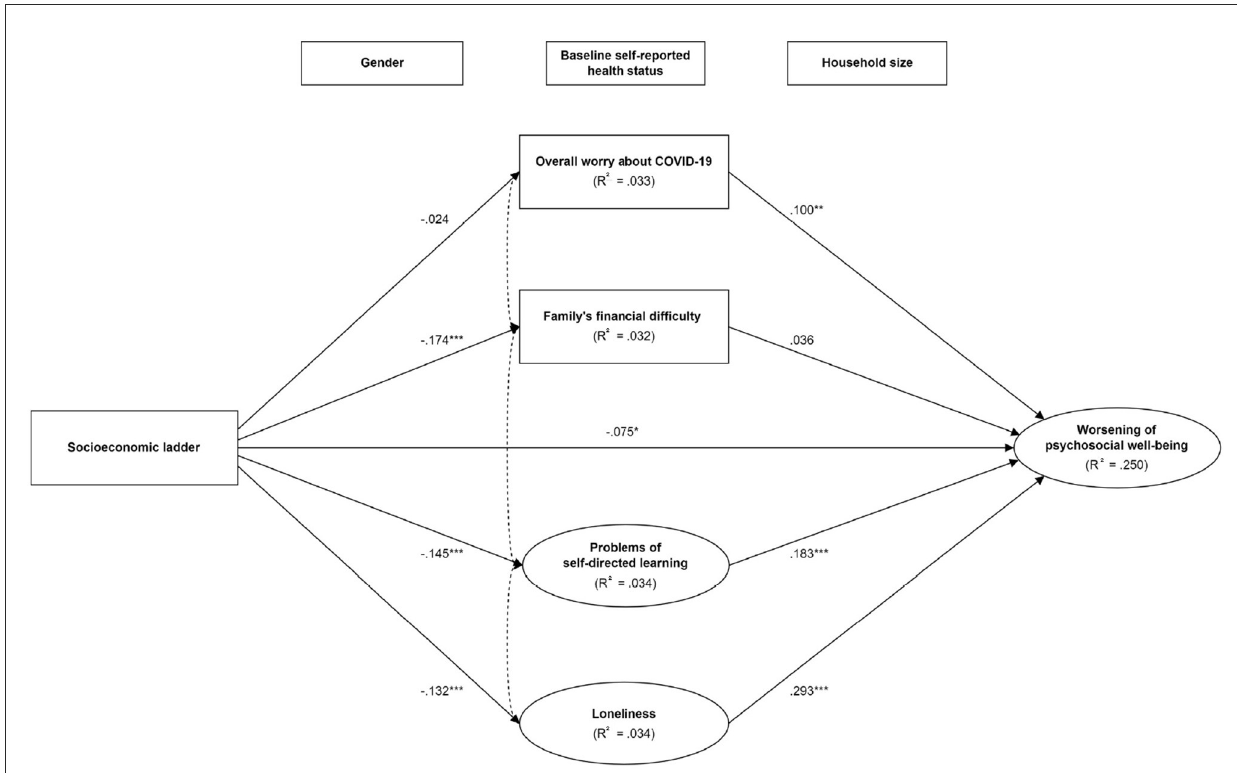
FIGURE1 The mediating pathways between socioeconomic position and the worsening of psychosocial wellbeing in the overall sample. * p < 0.05; ** p < 0.01; *** p < 0.001. Model was adjusted for gender, household size, and baseline self-reported health status. Covariance was specified in each of the possible pairs of mediators. The dotted double arrows between mediators are simplified for better